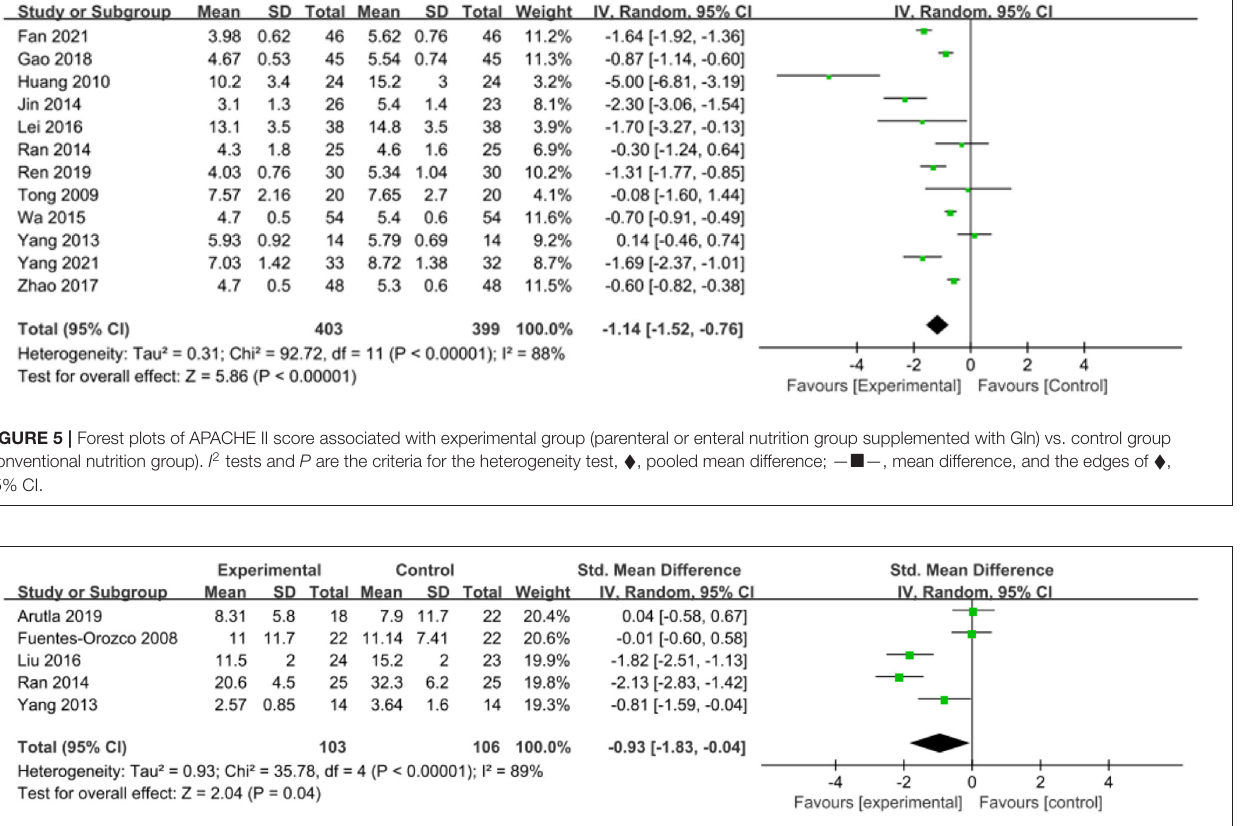
FIGURE 6 | Forest plots of ICU hospital stay associated with experimental group (parenteral or enteral nutrition group supplemented with Gln) vs. control group (conventional nutrition group). I 2 tests and P are the criteria for the heterogeneity test, (cid:7) , pooled standard mean difference; — (cid:4) —, standard mean difference, and the edges of (cid:7) , 95%